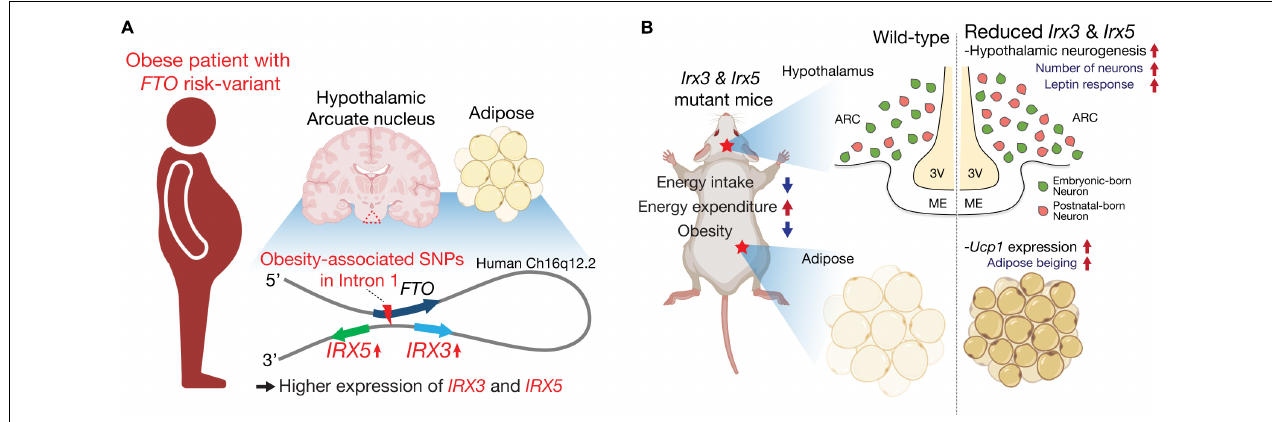
FIGURE 1 | IRX3 and IRX5 are effectors of FTO obesity-risk variants and key determinants of energy homeostasis. (A) IRX3 and IRX5 are located about a half-megabase downstream of FTO . In human brain, particularly hypothalamic arcuate nucleus (triangle with dashed lines in red) and preadipocytes, they mediate the effects of obesity-associated variants located in the first intron of FTO through long-range interactions. (B) Mice with mutations in Irx3 and/or Irx5 exhibit an anti-obesity phenotype with increased energy expenditure and reduced food intake. These metabolic phenotypes are related to beiging of white adipose tissue and improved response to leptin as well as increased postnatal neurogenesis in the mediobasal hypothalamus. Schematics were created using illustrations from